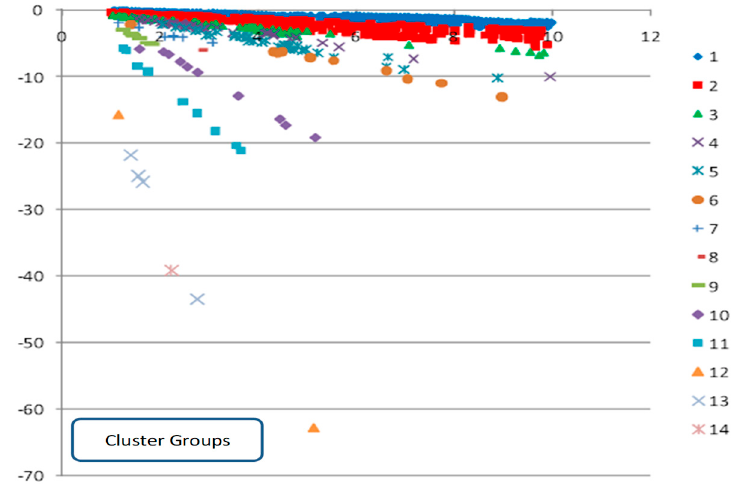
Figure 10. CRiPS-plot for 14 cluster groups. Table 4. Industrial structure of CBs in CG1 and CG2. Each cell denotes the number of CBs.